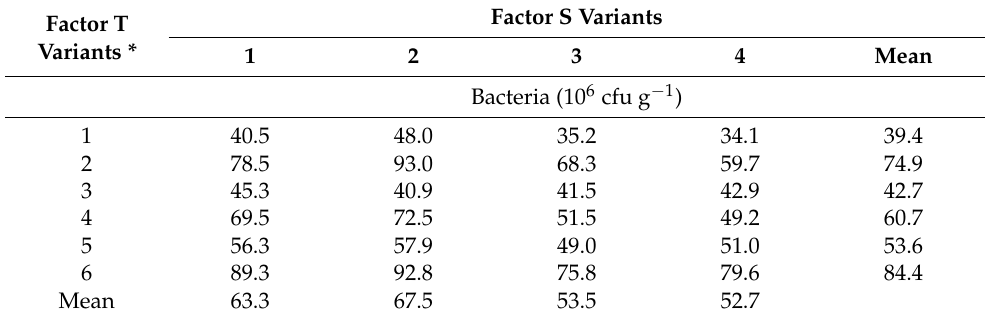
Table 4. The total number of bacteria, actinobacteria, and fungi in the soil, depending on the tillage method (factor T) and stubble management (factor S) in the spring wheat cultivation. Factor